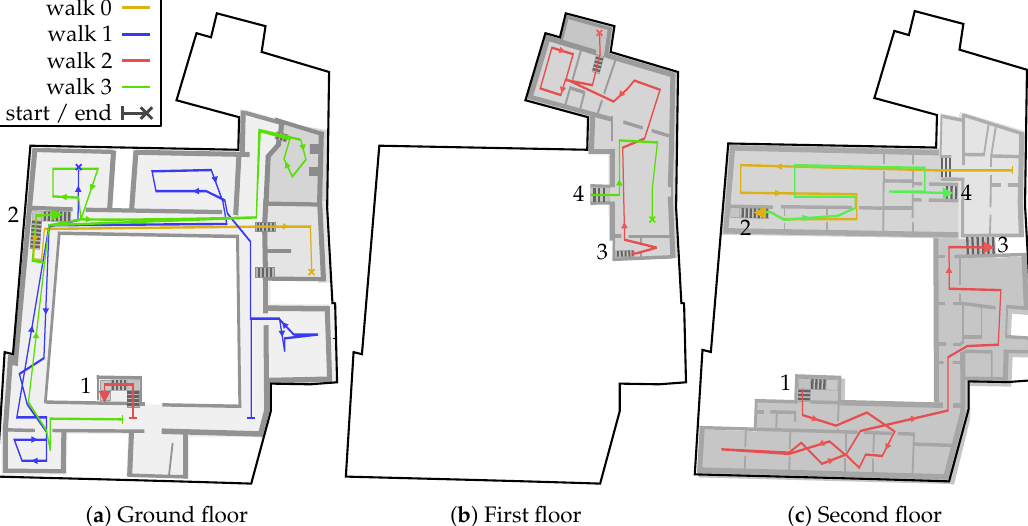
Figure 8. All conducted walks within the building. The arrows indicate the running direction and a cross marks the end. For a better overview we have divided the building into three floors, which are connected by four stairs (numbered 1–4). However, each floor consists of different high levels. They are separated from each other by different shades of grey, dark is lower than